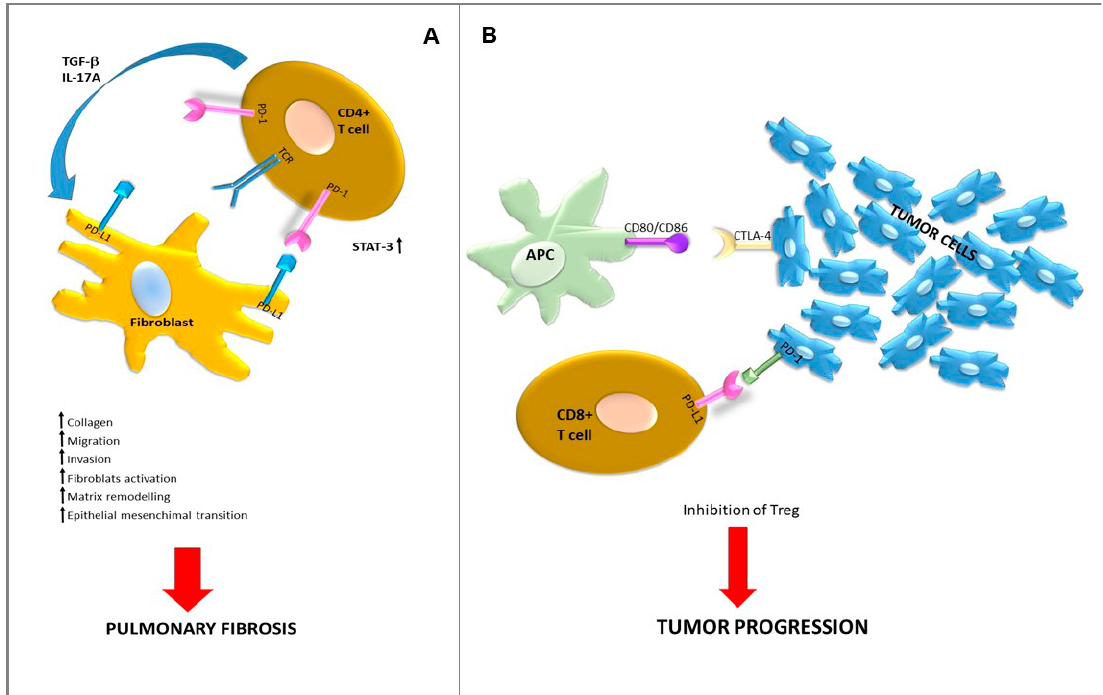
Figure 2. ( A ) Role of PD-1/PDL11 axis in development of pulmonary fibrosis. PD1 is expressed on CD4+ T cells whereas PD-L1 is expressed on fibroblasts. The interaction between receptor and ligand promotes IL17A and TGF- β production by the CD4+ T cells, through STAT 3, thus inducing pro-fibrotic responses by fibroblasts. ( B ) Role of PD-1/PDL-1 axis in the immune escape leading to progression of NSCLC. PD-1 is expressed by activated cytotoxic T cells whereas PDL-1 is expressed by lung cancer cells. The subsequent interconnection allows malignant cells to avoid the immune response, leading to tumor progression.